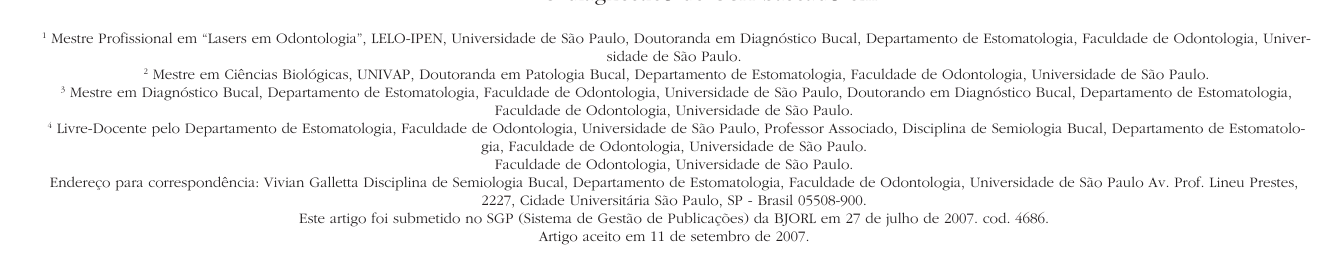
Figura 1. Apresentação inicial mostrando placa branca em mucosa de palato (A) e a lesão oposta no dorso de língua (B). Notar o contorno similar das